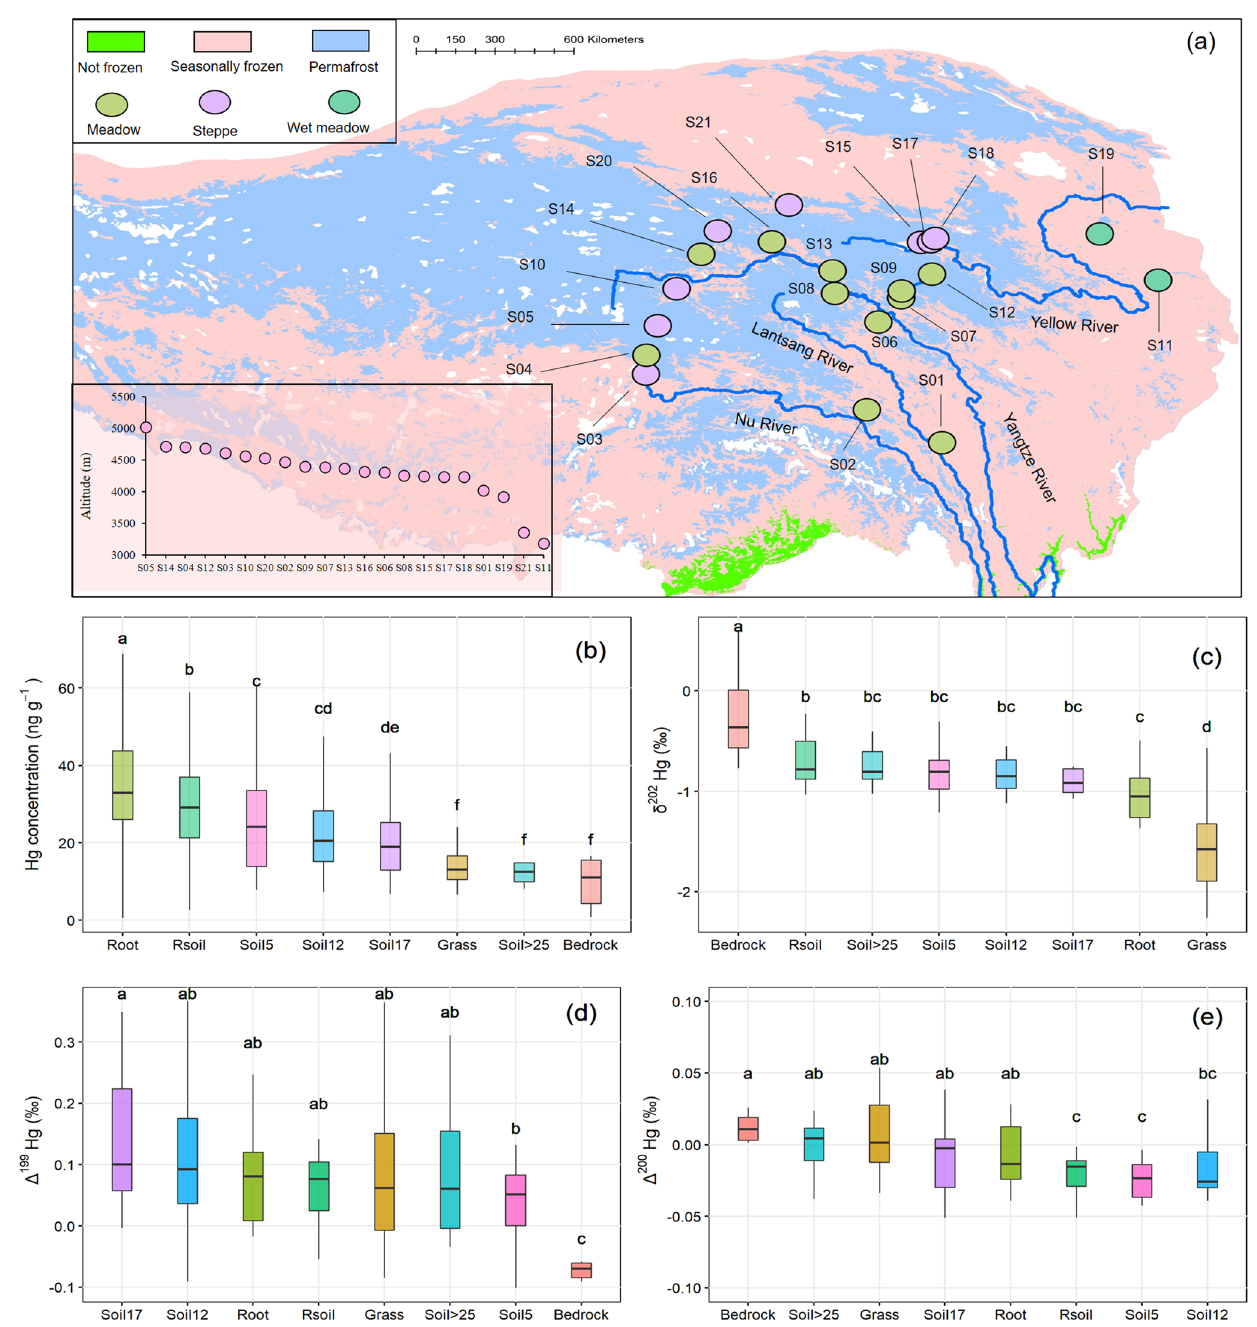
Fig. 1 Spatial distribution of mercury (Hg) concentration and isotopic composition in grass foliage, roots, and soil layers. a Site location, b Hg concentration, c δ 202 Hg ( ‰ ), d Δ 199 Hg ( ‰ ), e Δ 200 Hg ( ‰ ). The permafrost distribution in a is from the earlier study 76 . The term Rsoil means rhizosphere soil, and Soil5 is 0 − 5 cm depth soil, and Soil12 is 5 − 12 cm depth soil, and Soil17 is 12 − 17 cm depth soil, and Soil > 25 is the soil more than 25 cm depth. Boxplot elements in b – e show the median (midline), the interquartile range of 25% and 75% percentile (box boundaries), data points within the 1.5 × quartile range (whiskers). The letter in b , e donates the statistical difference at the 95% con fi dence level. clearly shown in Supplementary Fig. 5a. The soil organic matter the greater SOC produced by vegetative biomass likely also (SOC) in the surface soil comes from decomposition of litter, with retains a larger amount of Hg in soil through processes such as a higher soil SOC content acting to lower soil pH 34 . The complexation 19,20 . The Δ 199 Hg values of vegetative biomass signi fi cant correlation between soil Hg concentration and SOC (Fig. 2e) and surface soil (Fig. 2f) both increase with altitude. (Supplementary Fig. 5b), anticorrelation between soil Hg Given the reduced air pressure, lower temperature, higher UV concentration and pH (Supplementary Fig. 5c), and correlation irradiance and stronger winds at elevated altitude 35 , these correlations suggest that the change of climatic and environ- between aboveground grass biomass and soil Hg pool sizes mental conditions along with altitude may in fl uence the Hg (Supplementary Fig. 5d) all indicate an important role of accumulation in vegetation and soils. vegetation in promoting Hg accumulation in soils. In addition, COMMUNICATIONS EARTH & ENVIRONMENT| (2022) 3:287